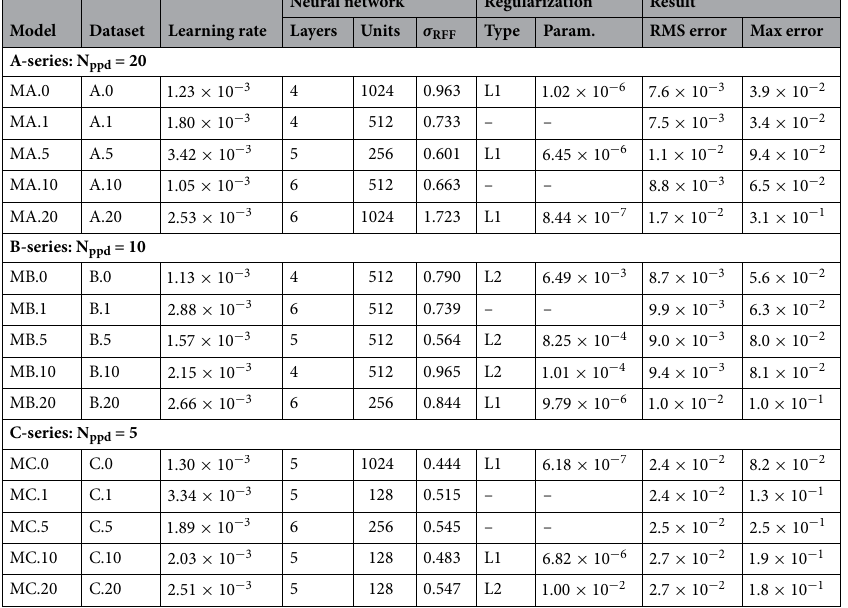
In the following we compute various statistics of the model prediction errors in which all gradient components are treated without distinction. This is feasible because the models are trained to learn the log of the labels, and the prediction errors correspond to relative errors (hence the axis label). It also means that the computed error refer equally to each component. Figure 6 shows a summary of the test-errors for the models in Table 3. For each model of the A-, B-, C- series the errors are computed with respect to the noiseless testset, i.e. the testsets of the A.0, B.0 and C.0 datasets respectively. Each row corresponds to a different N ppd (and parameter range domain PR- N ppd ), while each column corresponds to a different value of σ n , the noise in the flux dataset before applying Tikhonov’s regularization. The bias µ is typically negligible with respect to the variance term and, as it would be expected, in general the performance improves consistently for smaller values of the noise, σ n , and for denser datasets, i.e. larger N ppd . It 10, 20 , the MLP representations are charac- is interesting to note that for large values of the input noise, i.e. σ n = σ n / 2 2 σ reg , i.e. half the pre-regularization error but twice as large terised by an RMS error per component ≃ ≃ that of the regularised data (Supplementary Fig. S2). This is likely a consequence of the fact that the residual error noise in the regularised data is not purely Gaussian and the MSE is a less effective objective for closing in on the ground truth. Here, we also see that although in Supplementary Fig. S2 the error values for the regularised data at given percentile appear to plateau, MLP representations trained with more densely sampled datasets always shows an overall better performance. Below we show a more direct comparison of the models tested within the same parameter domain. In any case it is remarkable that we can obtain representations of the flux gradient with errors per components of only a few percent, despite an input relative error of the flux data of even 10%. Figure 7 shows more specific error statistics, in particular the RMS (blue dash line), Max (red dash line) and Bias values (yellow thin dash line), characterising the model predictions and their trend with the pre- regularization noise. From top to bottom, the rows correspond to errors computed using the noiseless testset of the C-, B- and A-series respectively, while from left to right the columns correspond to models trained with 20, 10 and 5, respectively. The half-filled points threaded by the black dash line correspond datasets with N ppd = to the case of equal relative error and input noise (the identity line, which would be diagonal in a linear plot). In general the error statistics appear to trace the value of the pre-regularization noise. The RMS value remains well below the identity line, consistent with the quality of the gradient data obtained after Tikhonov’s regulari- 10 − 2 . Since panels on the same row correspond to prediction errors sation, except at the low noise end, σ n ≤ computed using the same testset, their comparison shows that models trained with larger datasets, i.e. with larger N ppd are significantly more accurate. This is shown more specifically in Fig. 8 where the statistics presented in the top three panels of Fig. 7, relative to the PR-5 domain, are plotted as a function of N ppd in three separate panels. Although the data points are not aligned along straight lines, there appear to be a trend for the various statistics to decrease linearly with the parameter N ppd . Related to the improvement of the model performance as